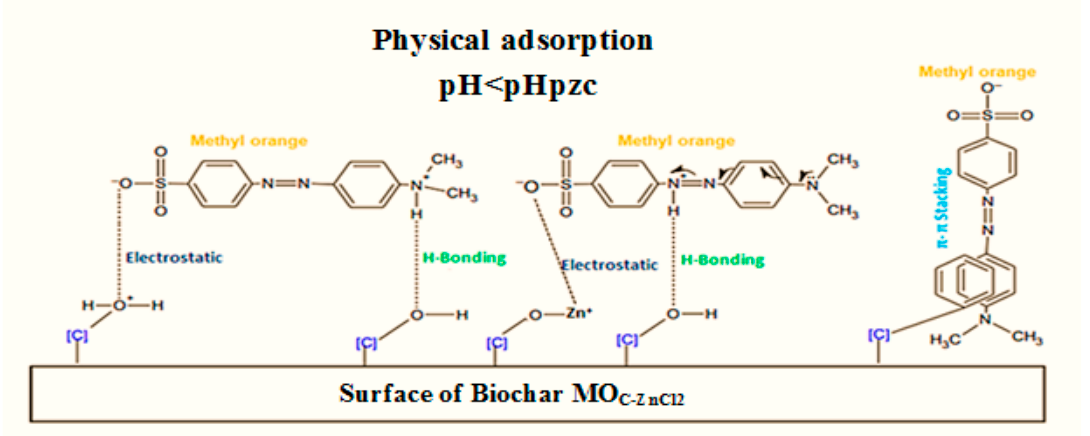
Figure 6. Proposed mechanism for the adsorption of MeO on MO C-ZnCl2.